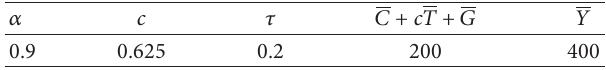
Table 1: Baseline